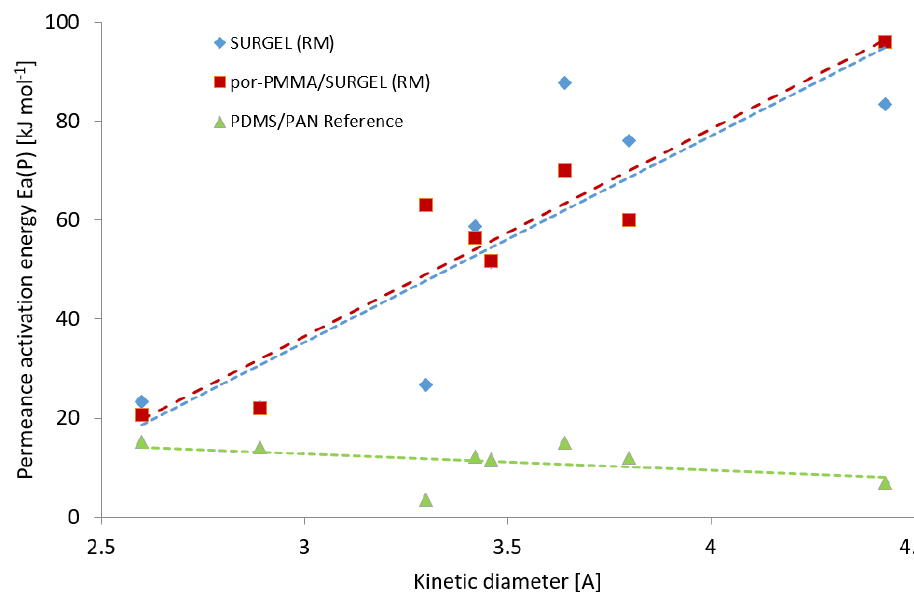
Figure 7. Dependencies of the permeance activation energy on the kinetic diameter of the tested gases for the PDMS / PAN membrane ( green triangles ), the SURGEL (RM) membrane ( blue diamonds ), and the por-PMMA / SURGEL (RM) membrane ( red squares ).